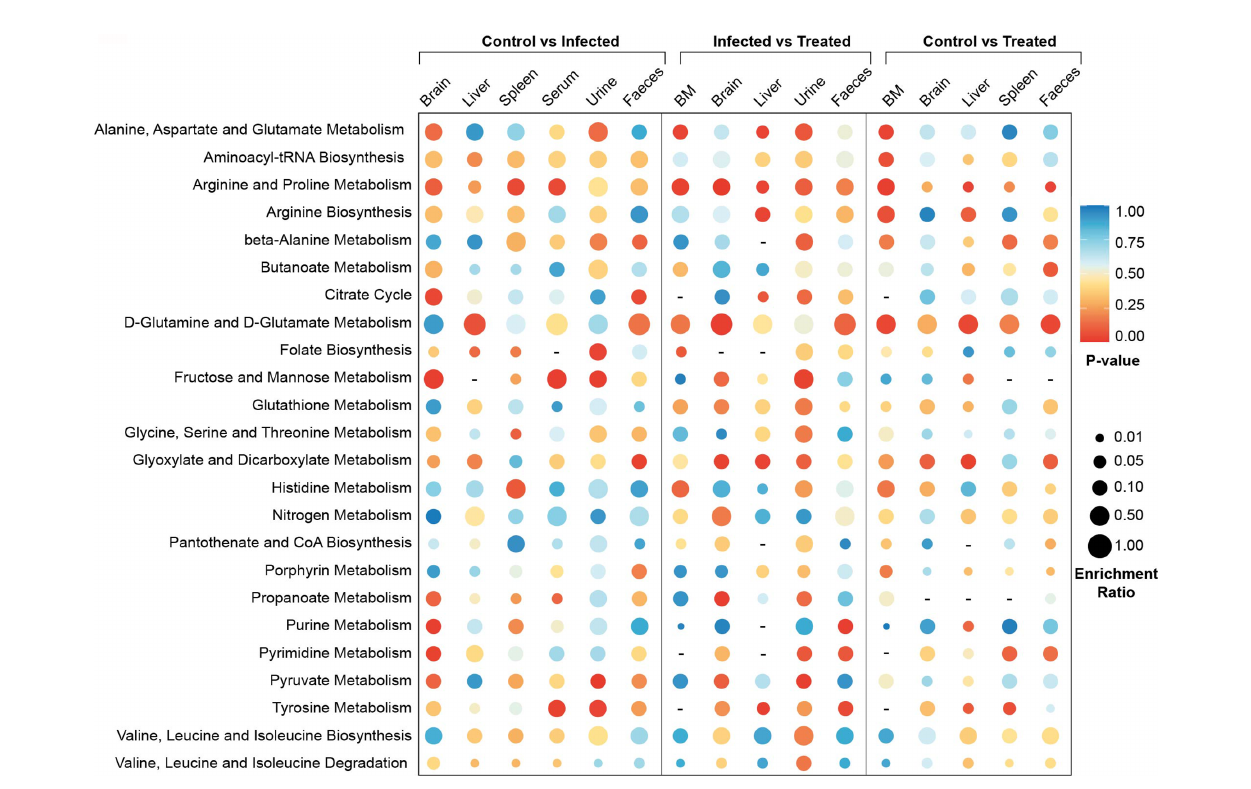
FIGURE 4 | MSEA meta-analysis. Meta-analysis of signi fi cant pathways in different comparison groups — control vs infected, control vs treated and infected vs treated. MSEA is a cut-off-free method that evaluates the overall differences of two distributions based on Kolmogorov – Smirnov tests. Mus musculus metabolome library from KEGG was used for the MSEA. Enrichment ratio was calculated as the relative percentage of the empirical compound hits to the whole empirical pathway is denoted as the size of the circles. Signi fi cance of each of the pathways in a particular context is represented by their p-value, which is assigned as the various colors of the